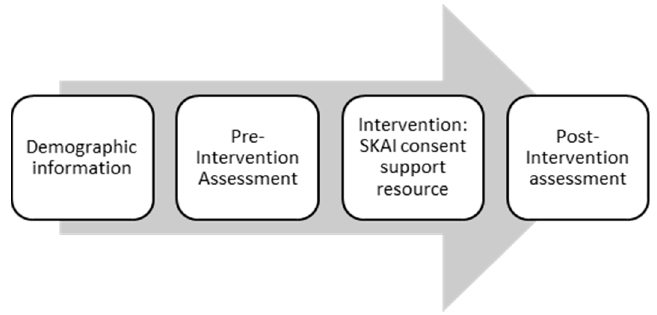
Figure 1. Survey Structure.